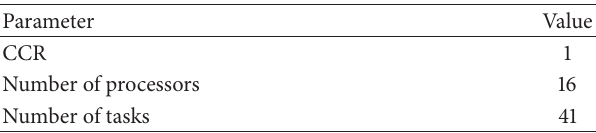
Table 16: Configuration parameters of convergence experiment for the molecular dynamics graph.